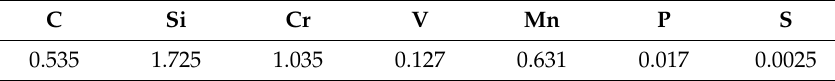
Table 1. Chemical composition of 60Si2CrVA steel